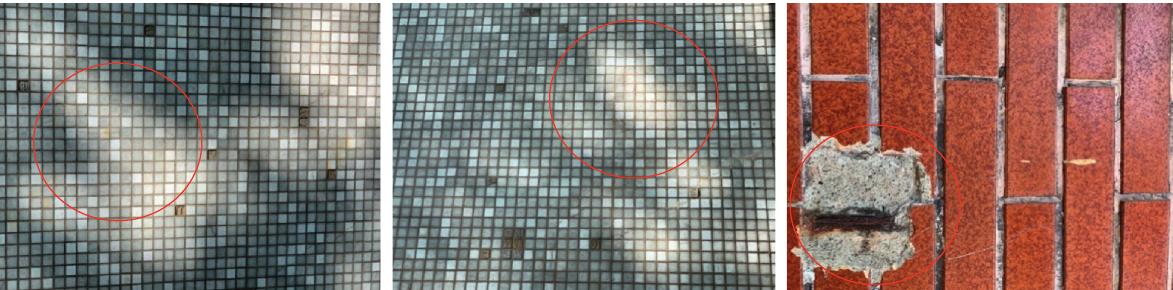
Figure 7: Spalling areas similar to